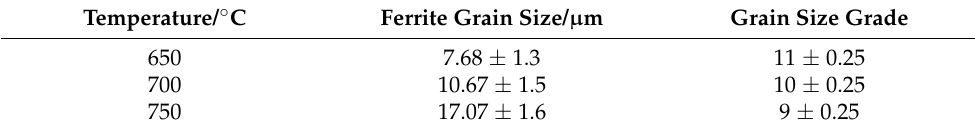
Table 2. Statistics of ferrite grain size and grain size grades of experimental steel.